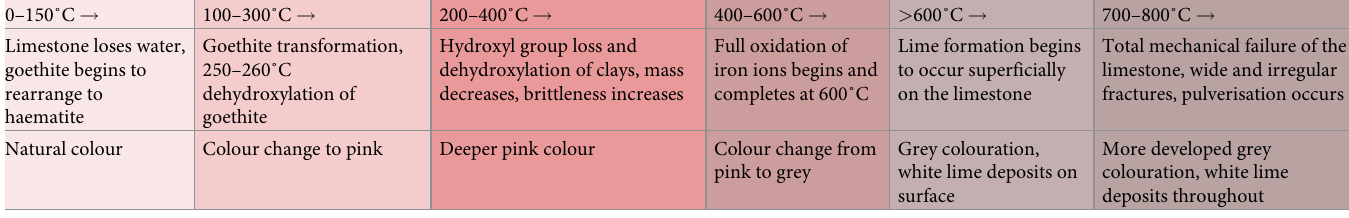
Table showing the changing material properties of limestone with increasing temperature. Observations derived from the following sources [86, 87, 89–98]. Overlaps in temperature ranges across categories reflect the observations presented by the papers cited, which record limestone in different circumstances, such as fires in buildings or controlled experiments where a steady temperature was maintained. The table therefore communicates a trajectory broadly applicable to any limestone undergoing heating but idiosyncrasies are to be expected when heating different limestones under varying actualistic